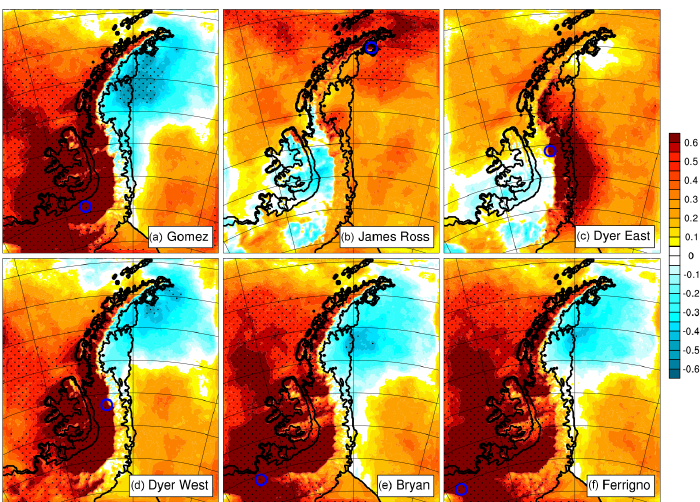
Figure 10. Correlation of modelled yearly (1979–2014) SMB at locations of Gomez ( a , 73 ◦ S, 70 ◦ W), James Ross Island ( b , 64.12 ◦ S, 57.54 ◦ W), Dyer Plateau East ( c , 70.4 ◦ S, 64.5 ◦ W), Dyer Plateau West ( d , 70.7 ◦ S, 64.9 ◦ W), Bryan Coast ( e , 74.3 ◦ S, 81.4 ◦ W) and Fer- rigno ( f , 74.3 ◦ S, 86.5 ◦ W) ice cores, with all other points in the model domain. Stippled pattern represents significant correlations > 99%. Locations of ice cores are denoted by blue circles. Note that over the sea-ice/ocean SMB = PR −